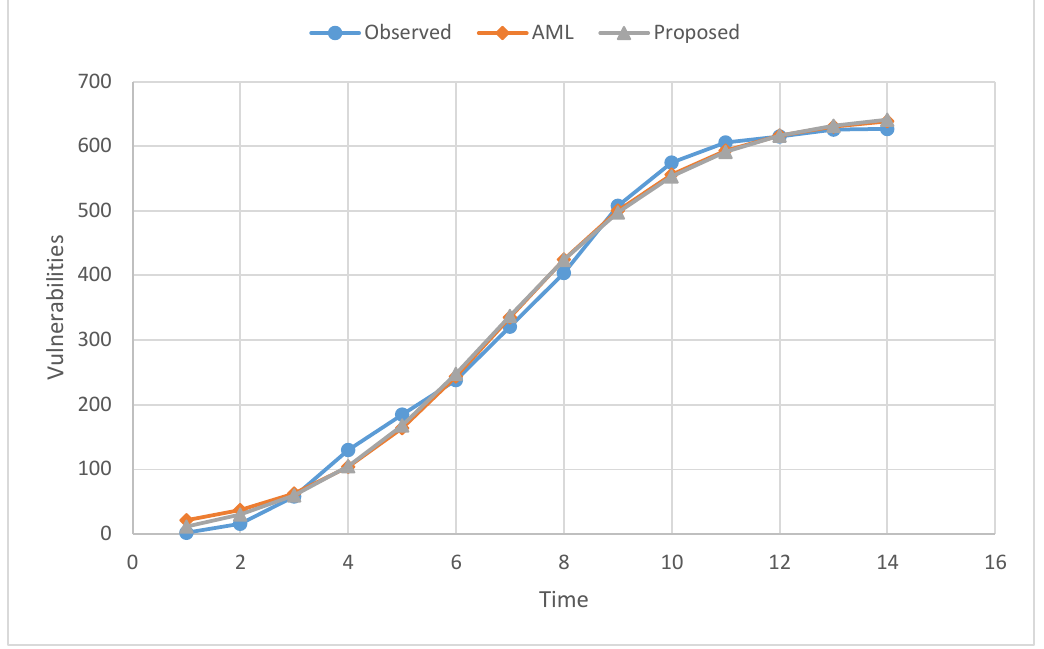
Fig. 6. Goodness of fit curve (Mac OS X Server)